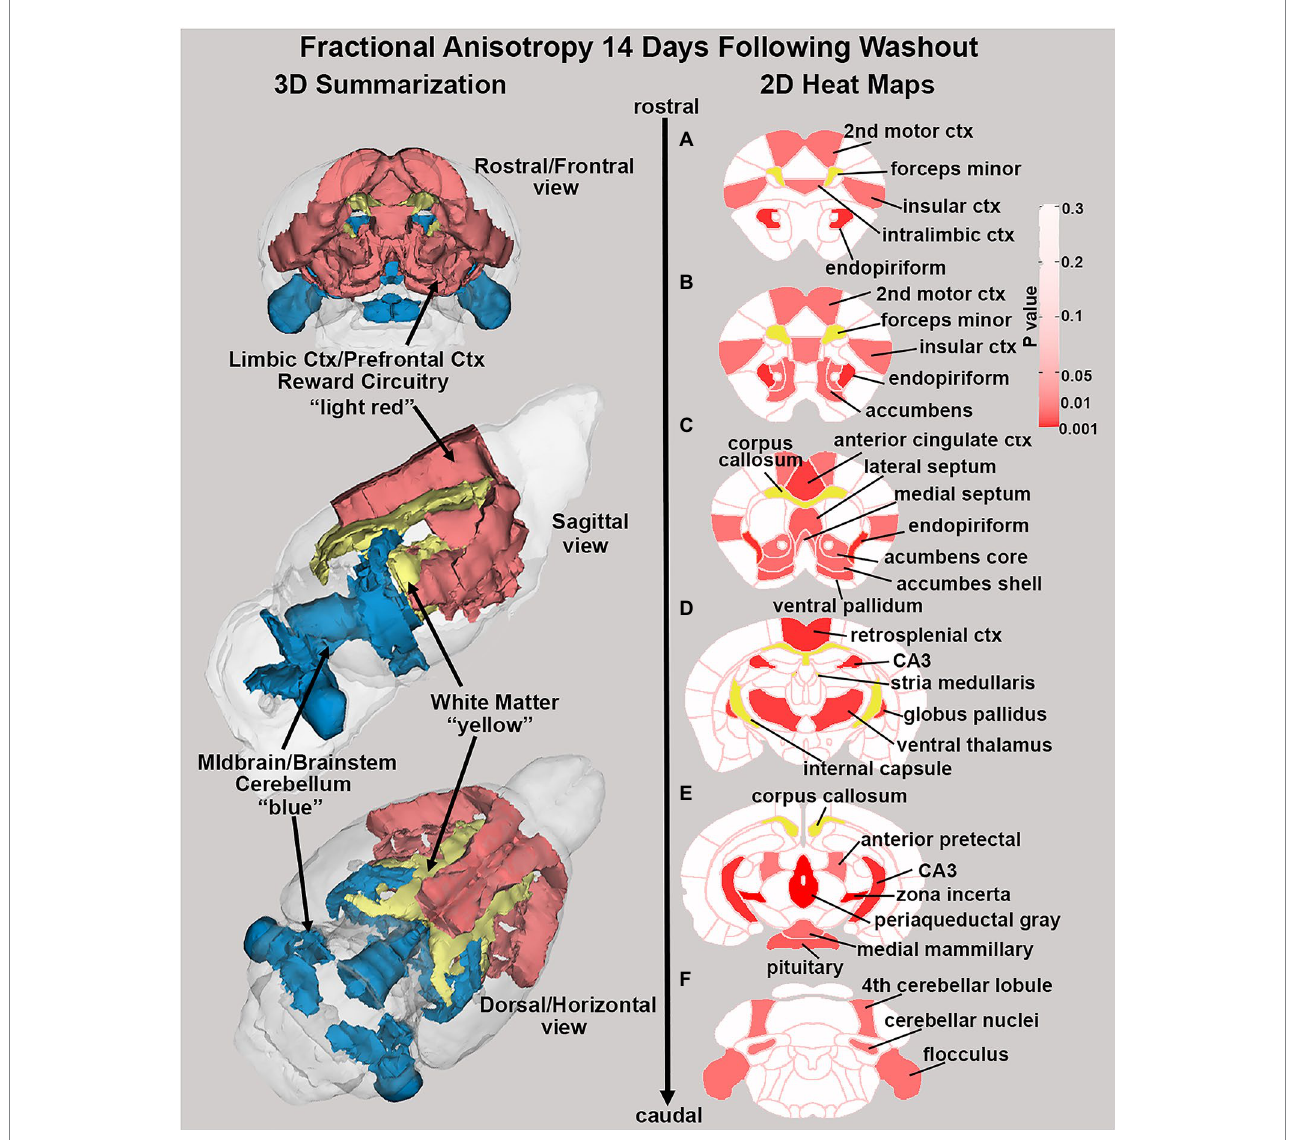
FIGURE 6 Changes in fractional anisotropy. Shown in the 2D heat maps to the right are brain areas with significantly different FA values following washout of Δ 9-THC as compared to placebo. These same areas are reconstructed as 3D volumes to the left. These data were taken from Table 4 and are aligned top (rostral) to bottom (caudal) as 2D axial sections (A-F) using the 3D mouse MRI